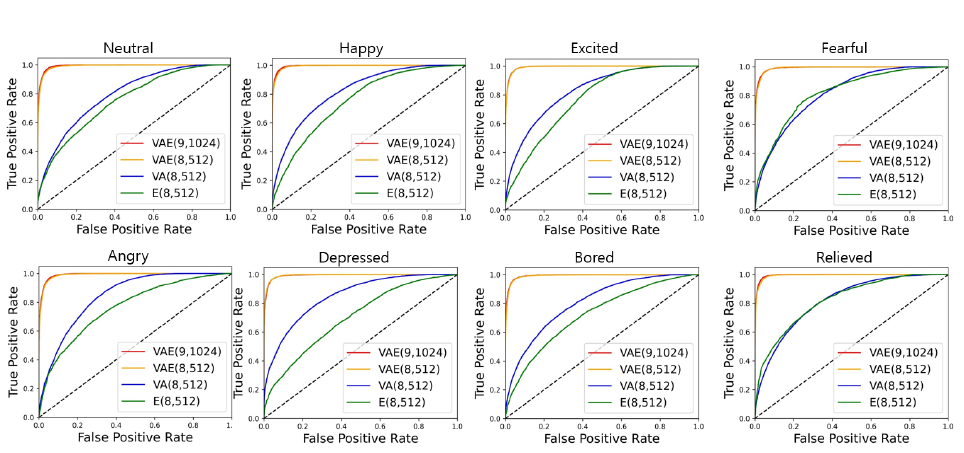
Figure 11. ROC curve for each defined emotion.